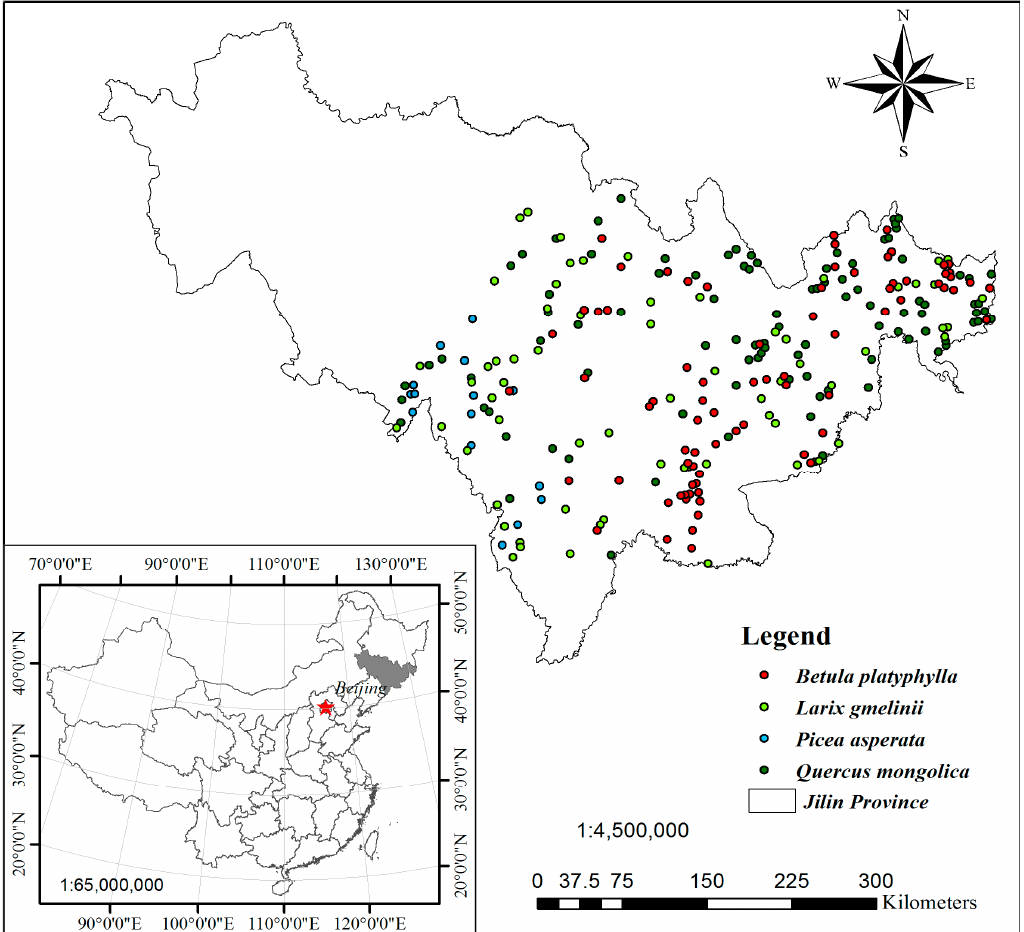
Figure 1. Permanent sample plots (PSPs) of four main natural uneven-aged pure stands (95, 72, 105, and 77 PSPs for Spruce, Korean Larch, Mongolian Oak, and White Birch, respectively, for a total of 349) distributed over almost the entire middle and eastern area of Jilin province. Figure was created using Esri ArcGIS 9.3 (http://www.esri.com/software/arcgis/arcgis-for-desktop).